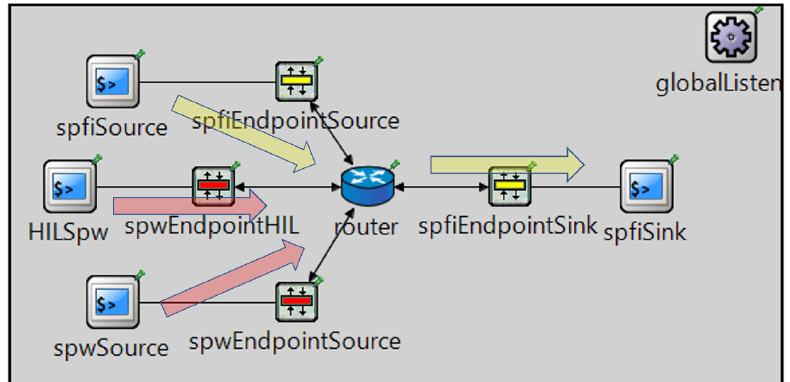
Figure 10. Example network simulated in SHINe.